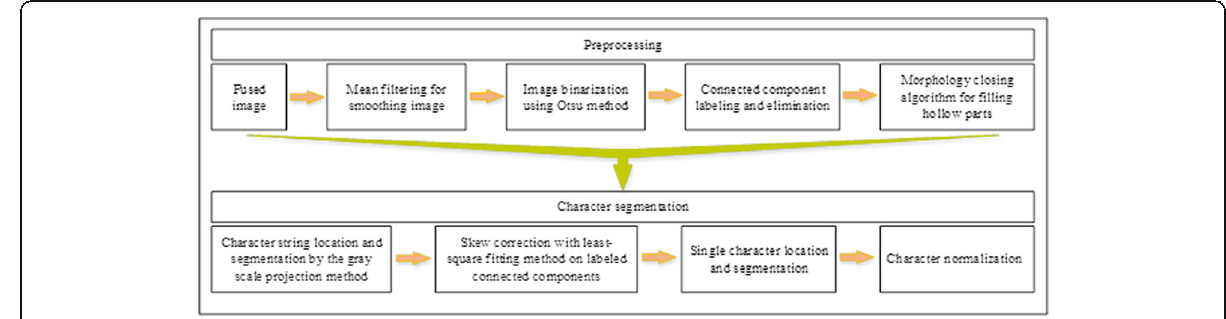
Fig. 4 Flow chart for character